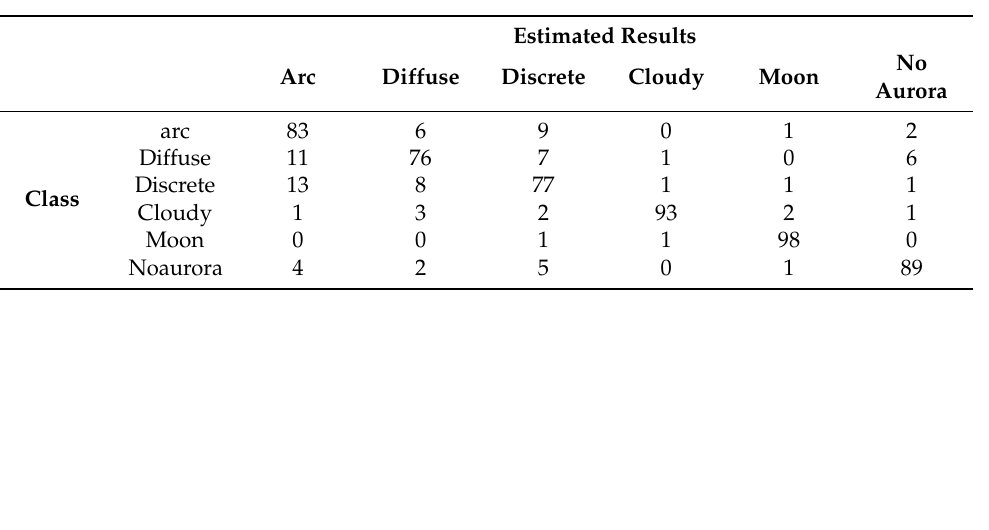
Table 4. Confusion matrices in the case of classification into six classes (Model